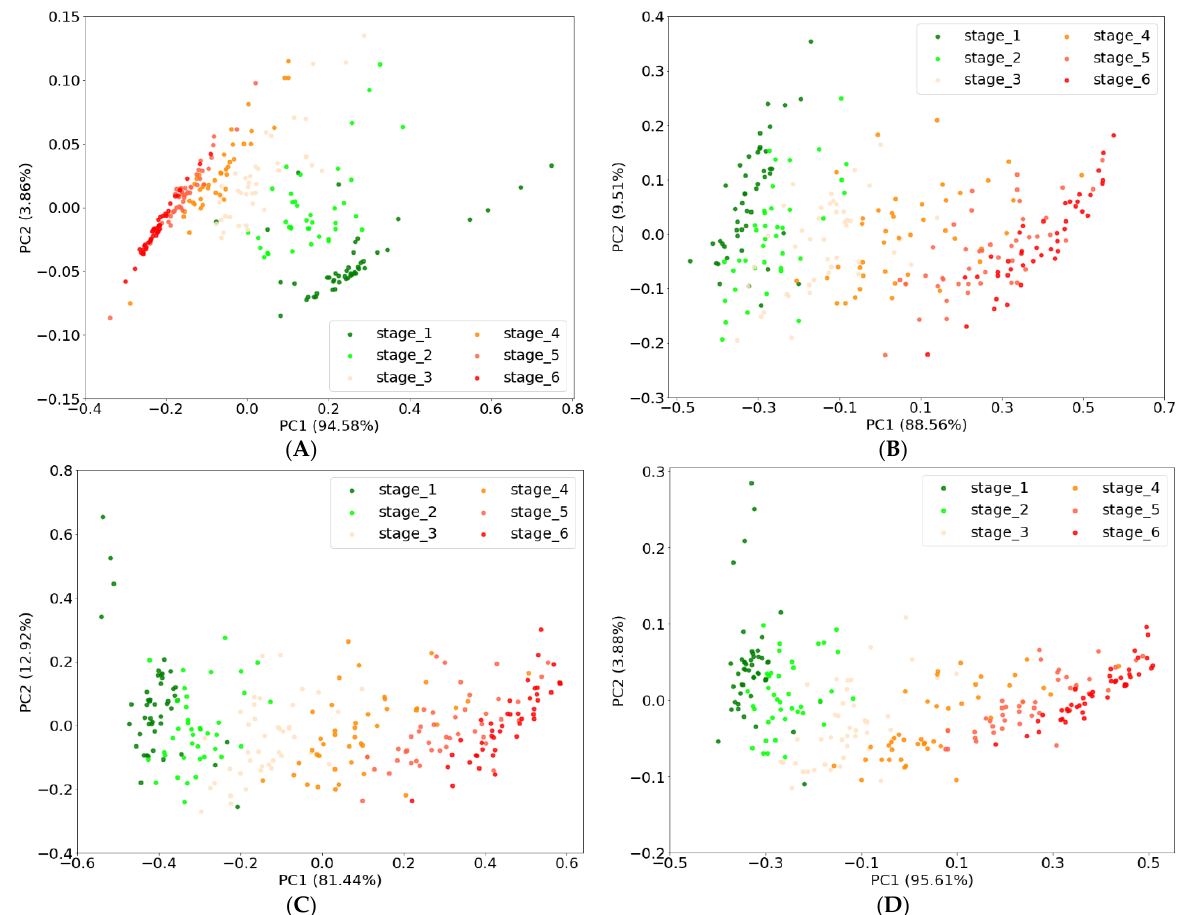
Figure 6. The PC1 and PC2 scores based on VIS data ( A ), Red-NIR data ( B ), combination data of VIS and Red-NIR data ( C ), and selected data from VIS and Red-NIR data ( D ). and Red-NIR data ( C ), and selected data from VIS and Red-NIR data ( D